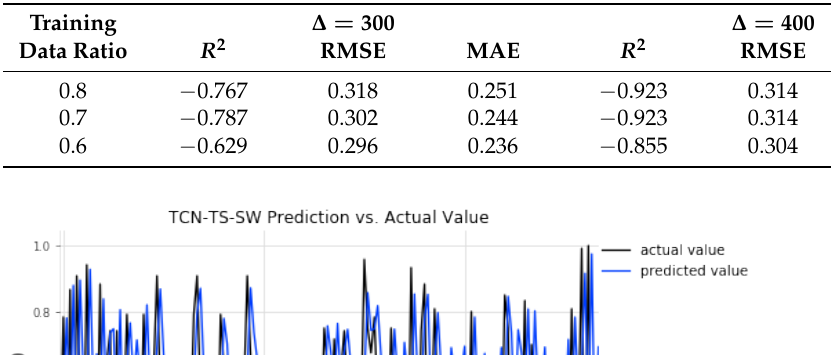
Table 4. Comparison Results for RMSE, MAE, and R 2 .